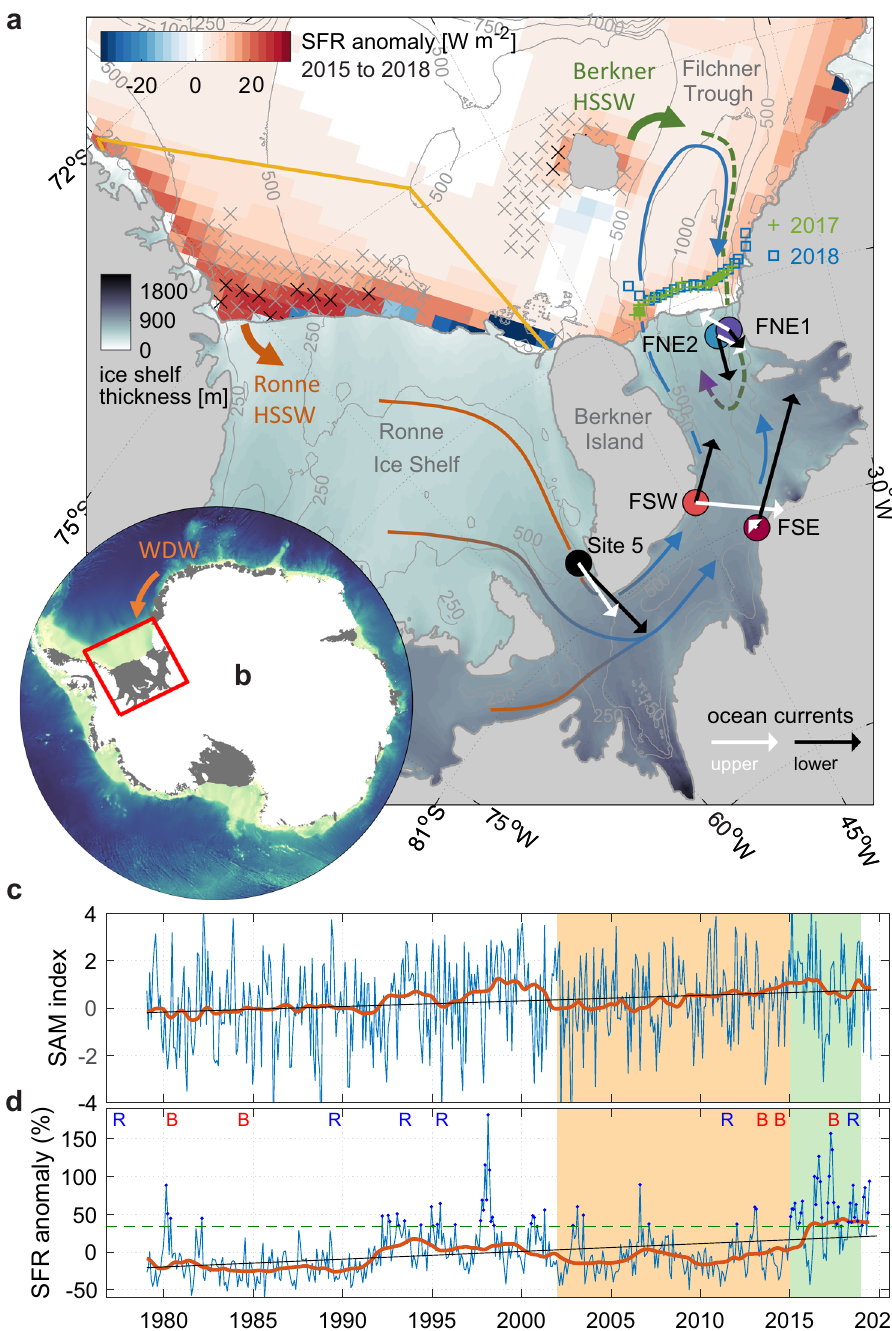
Fig. 1 Overview of the Filchner-Ronne Ice Shelf system. a Map of Filchner-Ronne hot-water drilled boreholes (Site 5, FSW, FSE, FNE1, & FNE2) and High Salinity Shelf Water (HSSW) production regions, ( b ) located south of the Warm Deep Water (WDW) that circulates along the continental slope in the southern Weddell Sea. a Contours: water column thickness (m); open ocean colors: anomalous sea ice formation rate (SFR) after 2015 compared with all years since 2002; blue (green) squares (crosses): ship-based CTD stations in front of the Filchner Ice Shelf in 2018 (2017); Vectors indicate time-averaged current meter observations from the lowest (black) and highest (white) instrument in the water column and legends showing a 2 cm s − 1 (10 cm s − 1 ) scale for the Filchner sites (Site 5). Colored arrows indicate inferred pathways and transformation from HSSW into ISW in the Berkner mode (green to purple) and in the Ronne mode (orange to blue). c Monthly and 36-month low-pass fi ltered time series of Southern Annual Mode (SAM) and ( d ) relative SFR anomalies, area-averaged over the orange polygon in front of Ronne Ice Shelf. Black lines: linear trend; blue dots: enhanced SFR events greater than 1 σ (green dashed line) above the time average; blue (red) letters: years of dominantly Ronne (Berkner) mode water masses in the Filchner Trough 21,22 . Black (grey) crosses in ( a ) indicate signi fi cant correlations between low-pass fi ltered time series of local SFR anomalies and SAM at 99% (95%) con fi dence level. Color shaded areas in ( c & d ) indicate the 15 year period (orange and green) relative to which the spatial pattern of SFR anomalies (green only) is computed that is shown in ( a